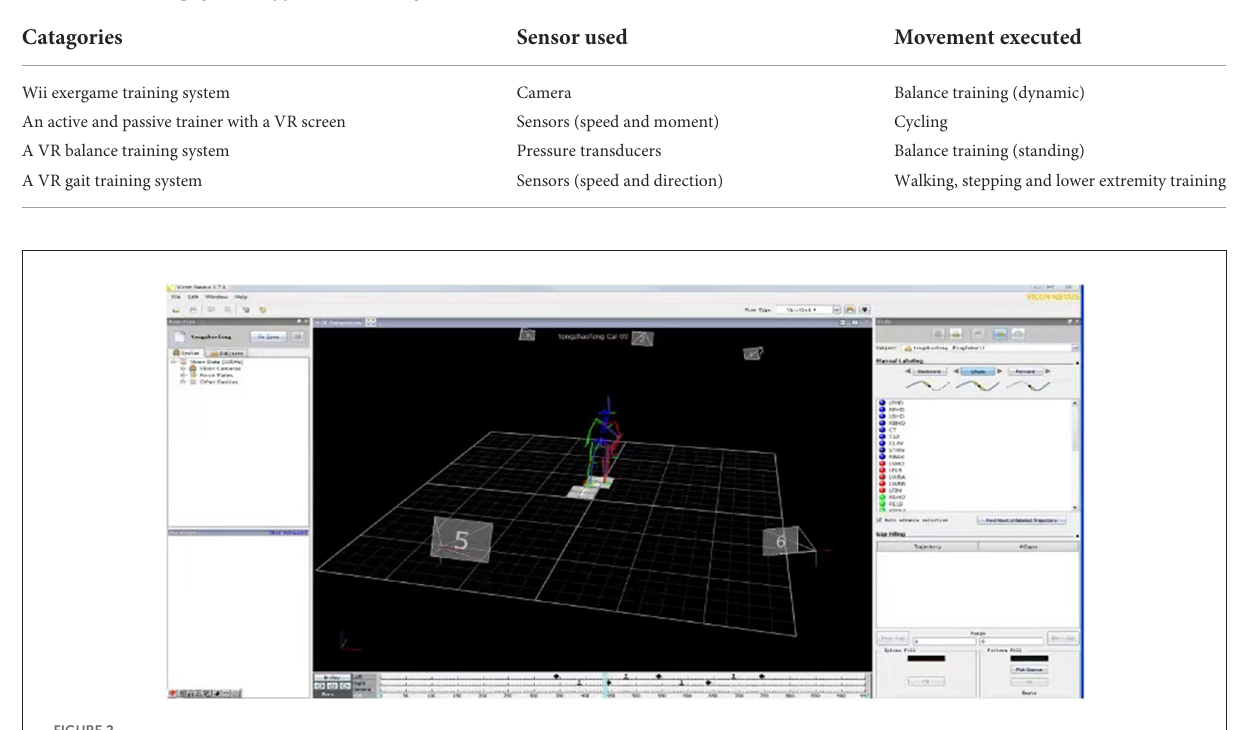
FIGURE2 Three-dimensional data